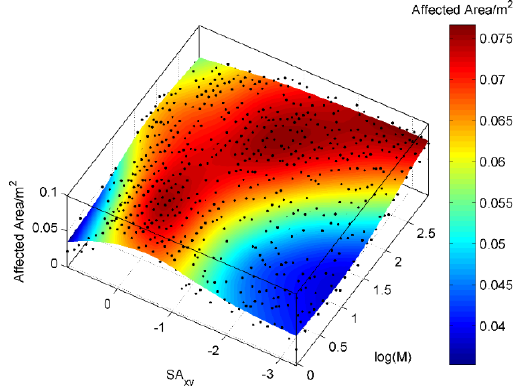
Figure 16. The variation of affected area with SA and M . The result of each simulation is represented by a black point. The affected area smoothed from the data points is represented by the colored